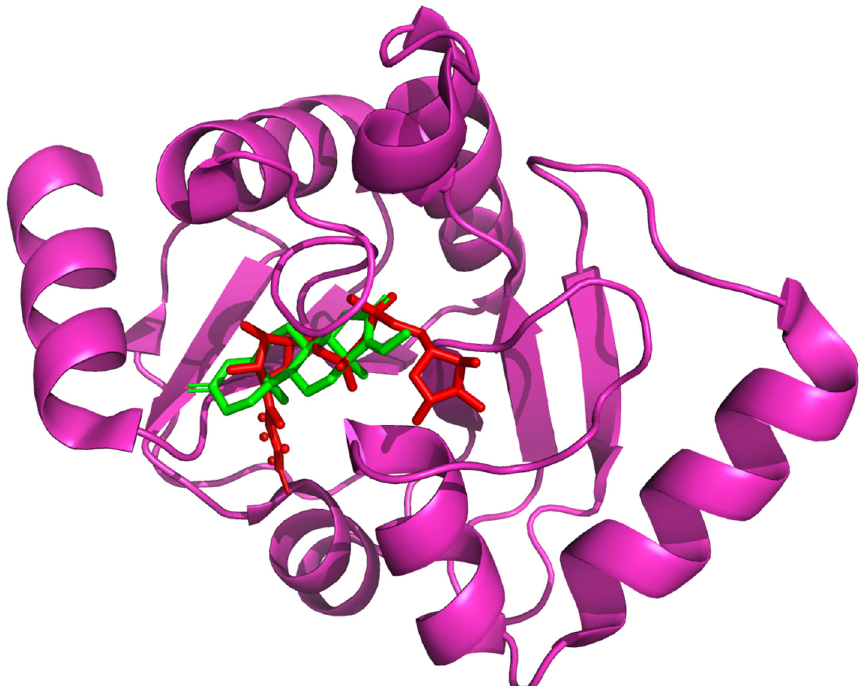
Figure 3. Comparative binding pose of the docked ligand guggulsterone (green) to the native pose of the reference crystallized ligand ADP ribose (red) within the active binding site of the viral ARP enzyme.